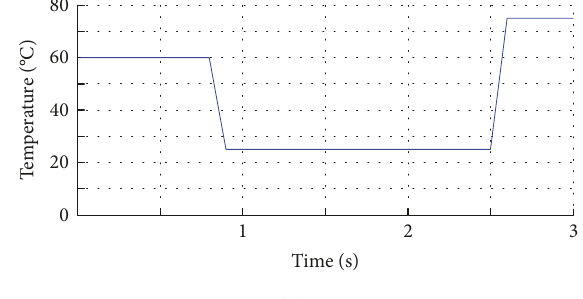
Figure 8: Temperature.